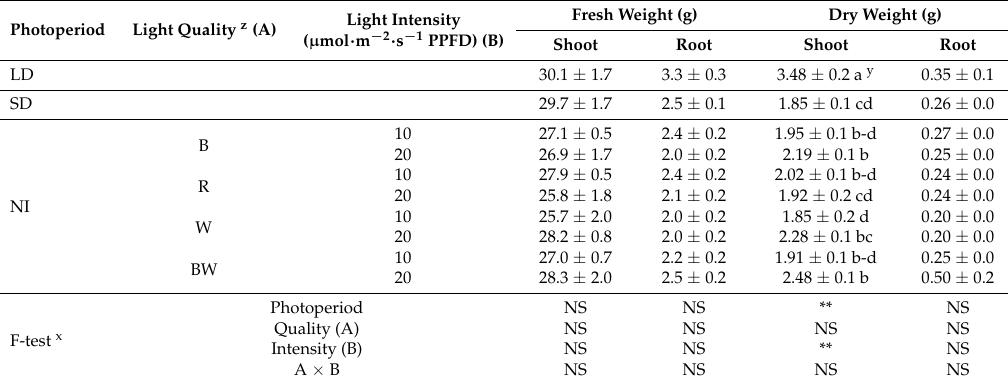
Table 1. The effect of the night interruption light (NIL) quality at 10 or 20 µ mol · m − 2 · s − 1 PPFD on the fresh and dry weights of kalanchoe ( Kalanchoe blossfeldiana ) ‘Lipstick’ shoot and root measured 98 days after treatment initiation.